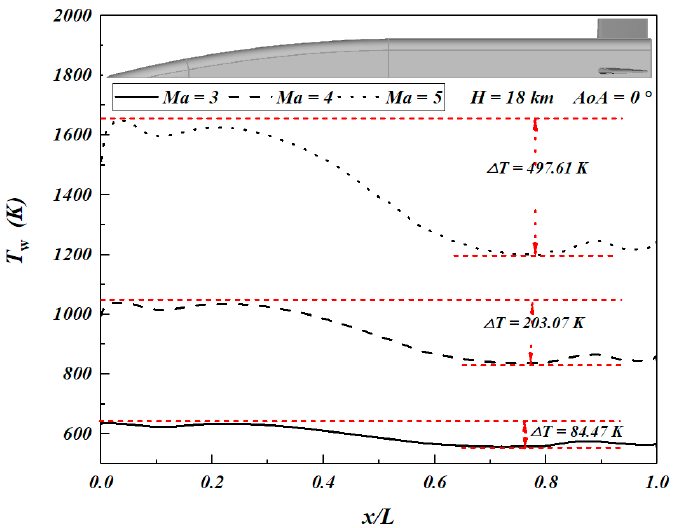
Figure 7. Variation trend of wall temperature along x/L at the axis of the aircraft and its maximum temperature difference. temperature